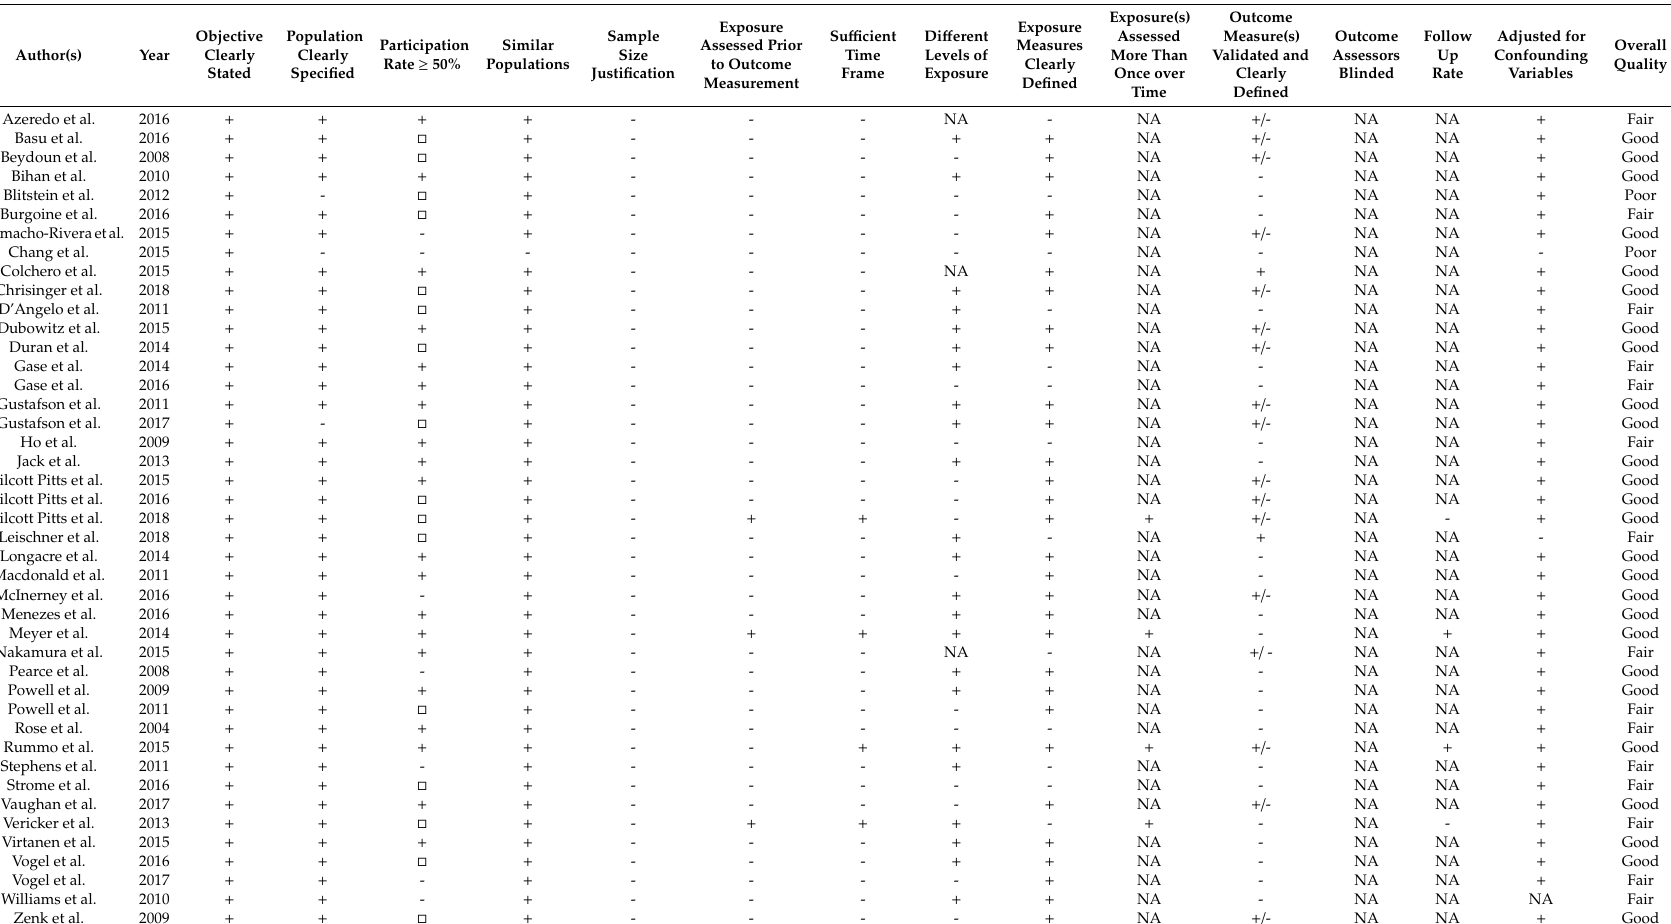
Table 4. Quality Assessment of included